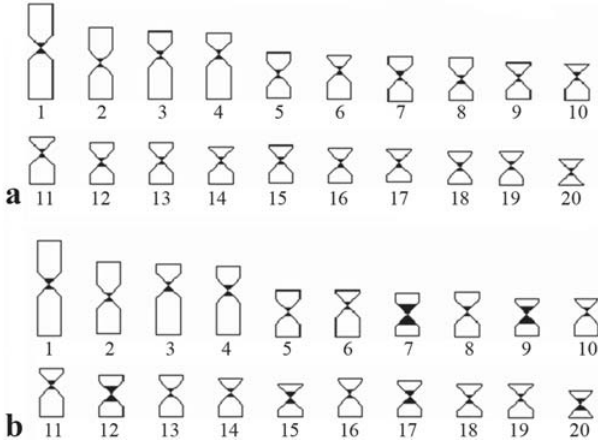
Fig. 4. Comparative ideogram between Hoplias malabaricus populations from Contas River (a) and Itapicuru River (b)